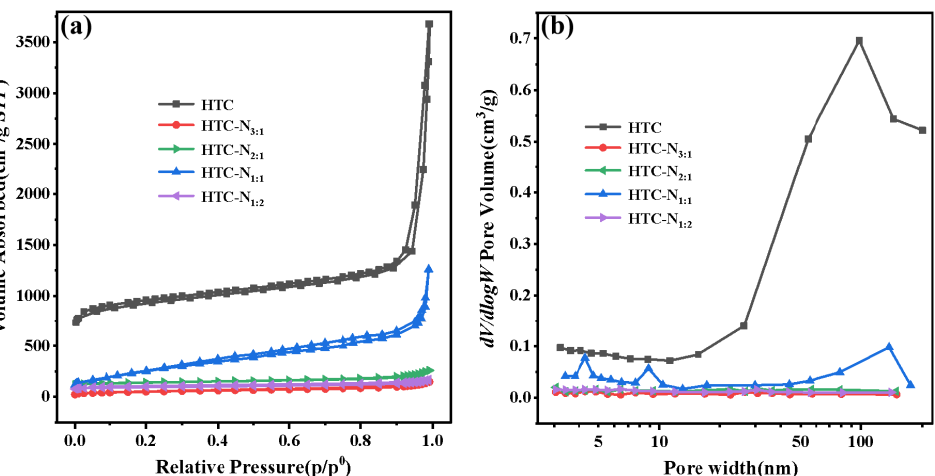
Figure 2. N 2 absorption – desorption isotherms ( a ) and pore-size distribution curves of the carbon supports ( b ). Table 1. Textural and structural properties of the carbon supports.